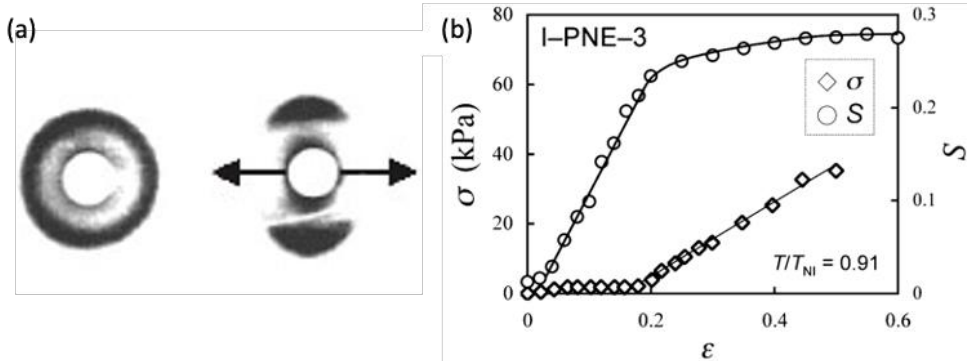
Figure 2. Polydomain–monodomain transition of LCN induced by stretch ( a ) X-ray scattering patterns of the polydomain ( left ) and monodomain ( right ) texture (Adapted with permission from Ref. [31]. 1998, S. M. Clarke); ( b ) stress–strain and order parameter–strain relationships in polydomain nematic elastomers (PNE), illustrating semi-soft elasticity behavior and the correlation between stress, order parameter (S), and strain ( ϵ ). (Adapted with permission from Ref. [30]. 2009, Kenji Urayama et al.).